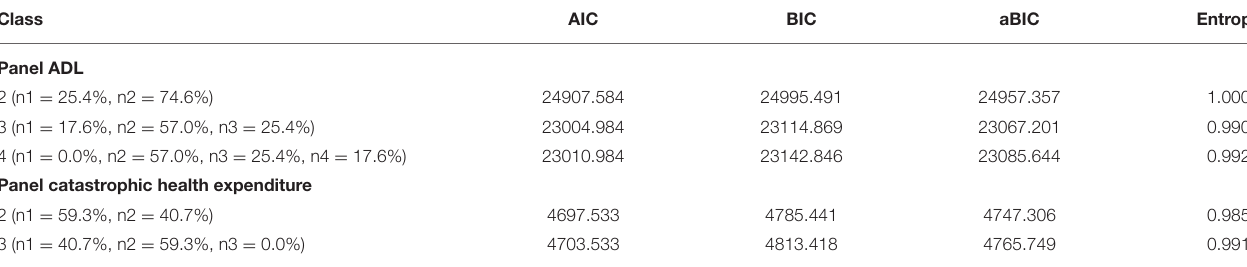
TABLE 2 | Model fit indices for longitudinal latent class analysis on ADL and catastrophic health expenditure over